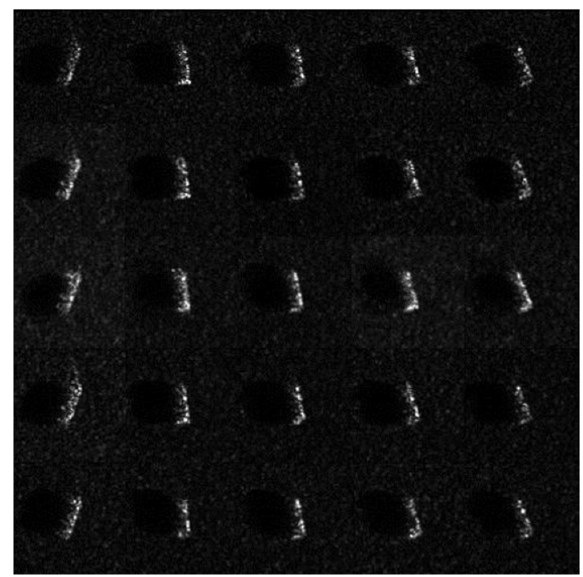
Figure 10. Partial azimuth reconstruction results of BTR70.